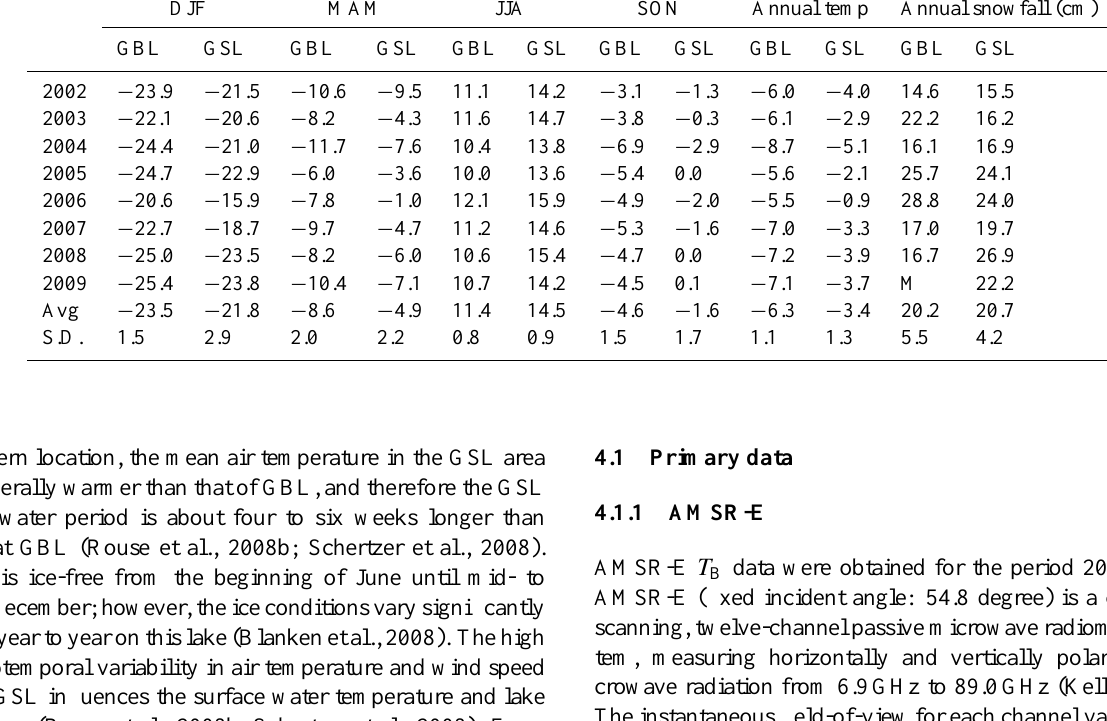
Annual snowfall